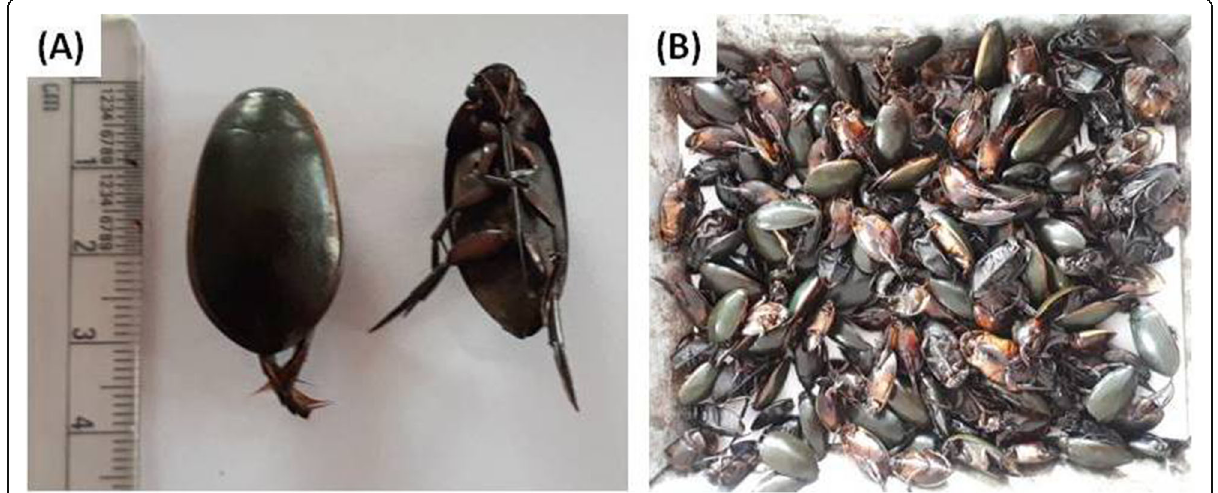
Fig. 2 Dytiscus marginalis Linnaeus, 1758